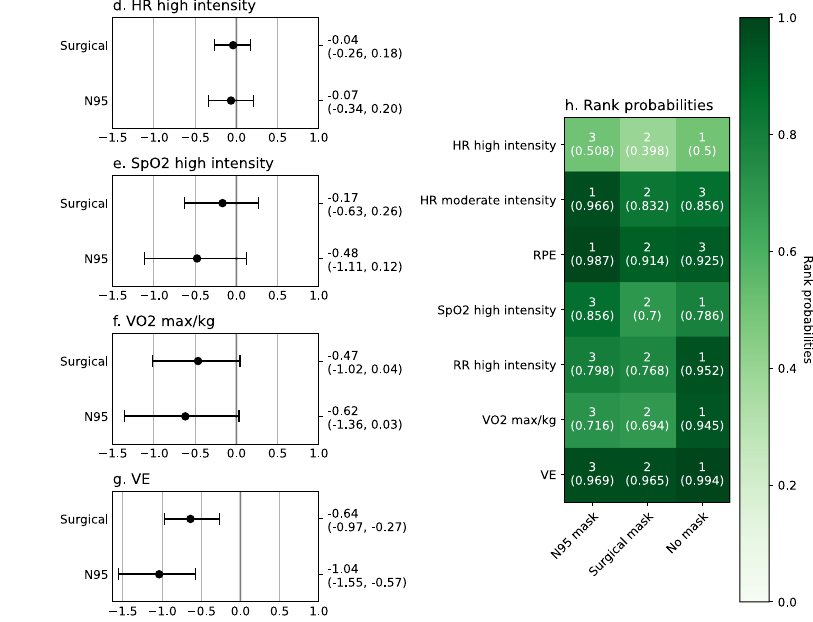
Figure 6. Network meta-analysis of N95 filtering facepiece respirators and surgical masks effects on physiological outcomes during moderate and high-intensity exercises. Numbers in rank probabilities heatmap represent rank with the highest probability and corresponding probability for given measure and condition; RPE a perception of exertion, HR heart rate, VE ventilation, VO 2 oxygen